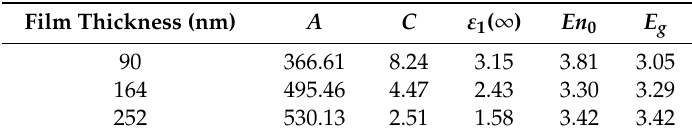
Table 1. The values of the analytical parameters from the Tauc-Lorentz model for PZT film with di ff erent thickness.